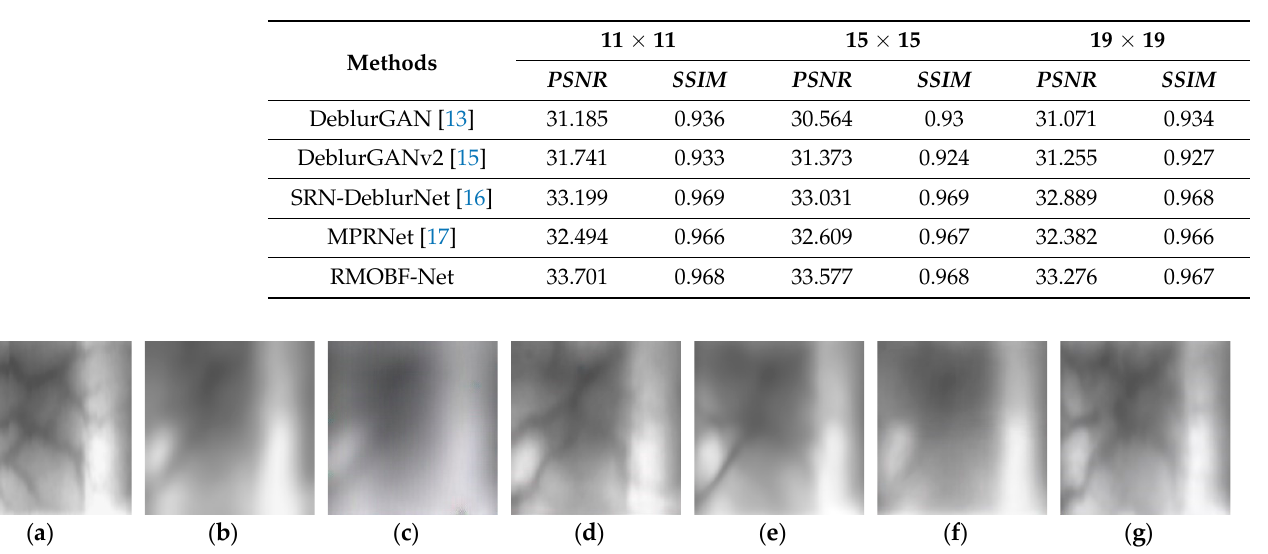
Table 6. Comparison of finger-vein recognition error (EER) with and without motion and optical blur application and restoration in SDU-DB according to different finger-vein recognition methods (unit: %) (random motion blur and optical blur with intensity 19 × 19 (Gaussian filter size) and 19 (Gaussian filter standard deviation)).